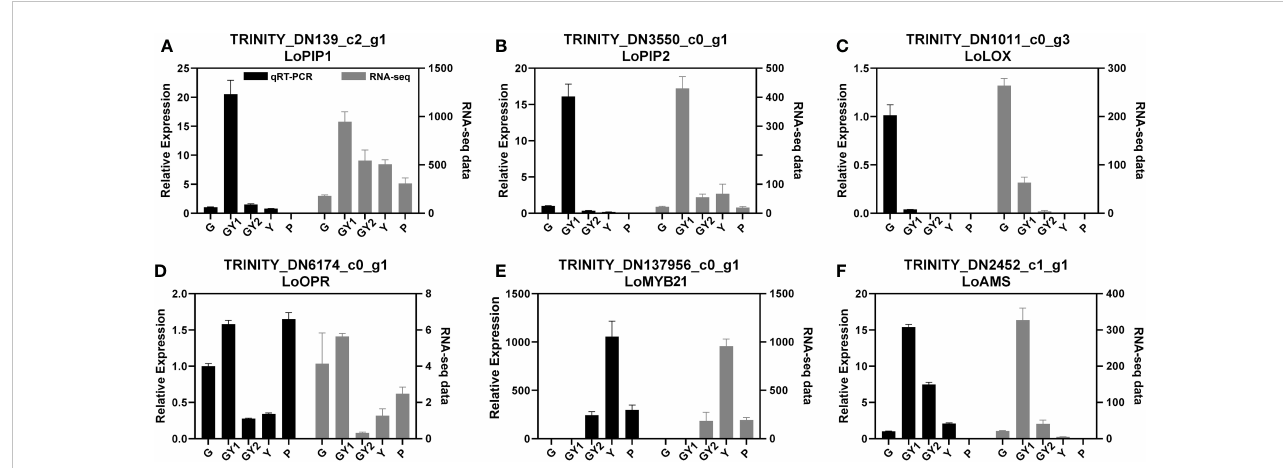
FIGURE 6 Relative expression of genes selected for validation of RNA-sequencing results by quantitative real-time PCR analysis. The genes comprised aquaporin-, jasmonic acid-, and transcription factor-related genes. The 18S rRNA gene was used as an internal control. Error bars represent the SD. Three biological replicates were analyzed.